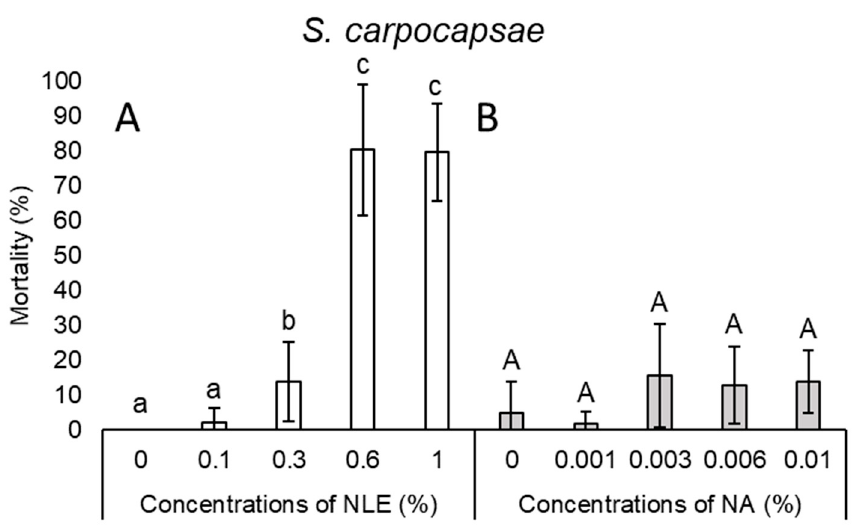
Figure 3. Mortality after 24-h exposure time of Steinernema carpocapsae juveniles of 0.1%, 0.3%, 0.6%, and 1% NLE ( A ) and 0.001%, 0.003%, 0.006%, and 0.01% of NA ( B ). (One-way ANOVA, Mann– Whitney U test ( A ), Tukey’s pairwise comparisons ( B ); the same letters indicate no significant difference at p < 0.05 level) .